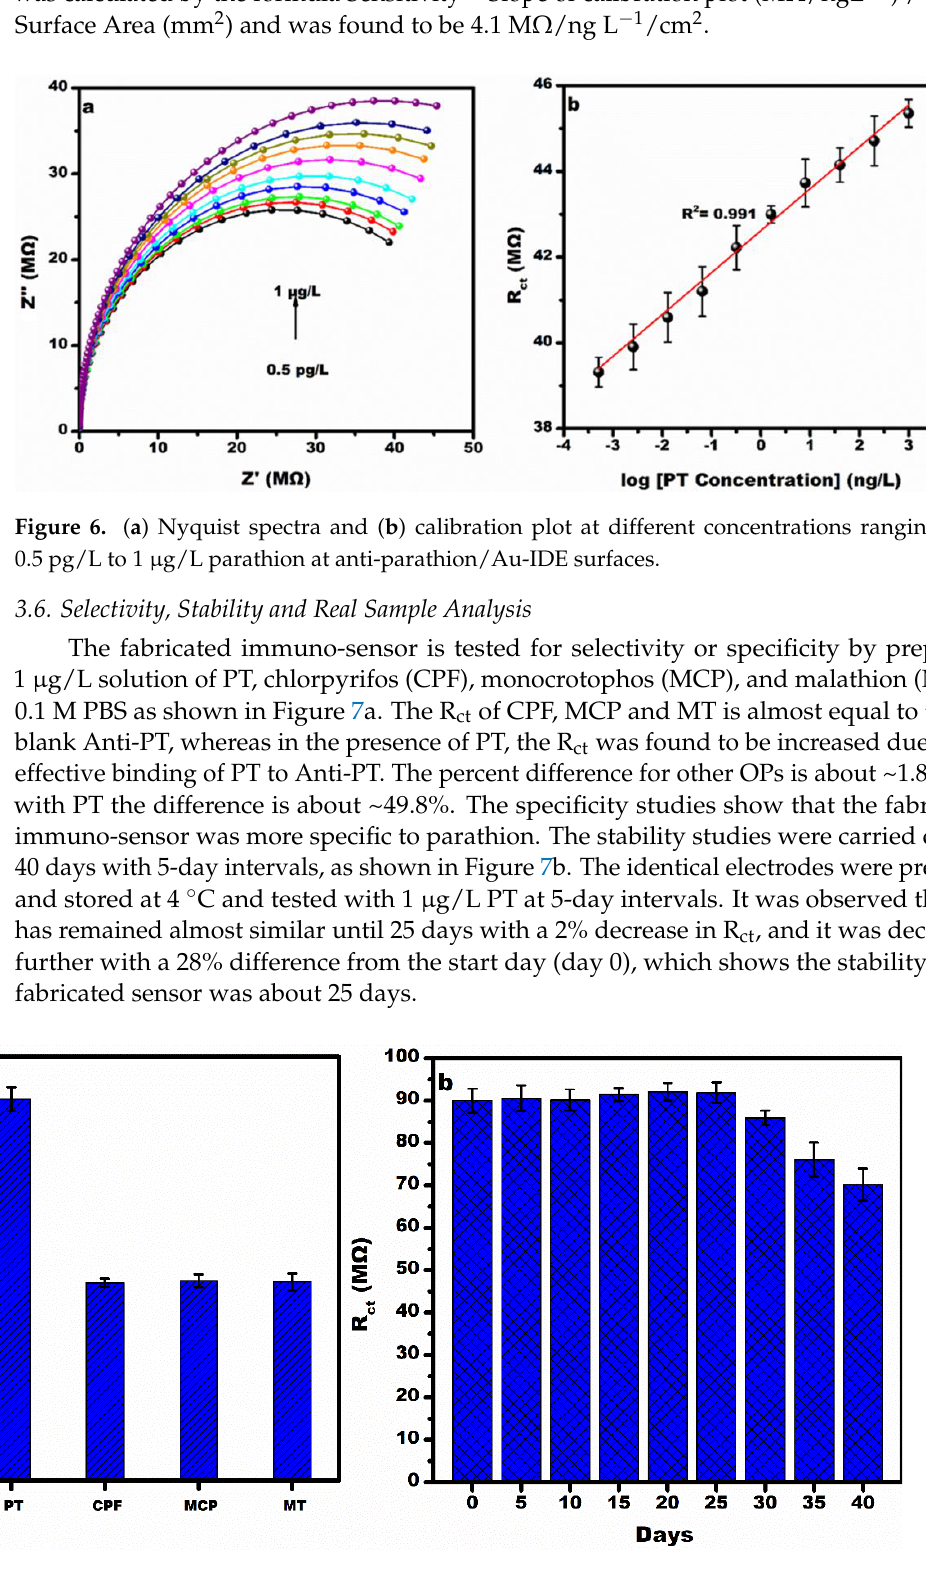
Figure 7. ( a ) Selectivity and ( b ) stability studies for anti-parathion/Au-IDE at concentration of 1 µg/L parathion.